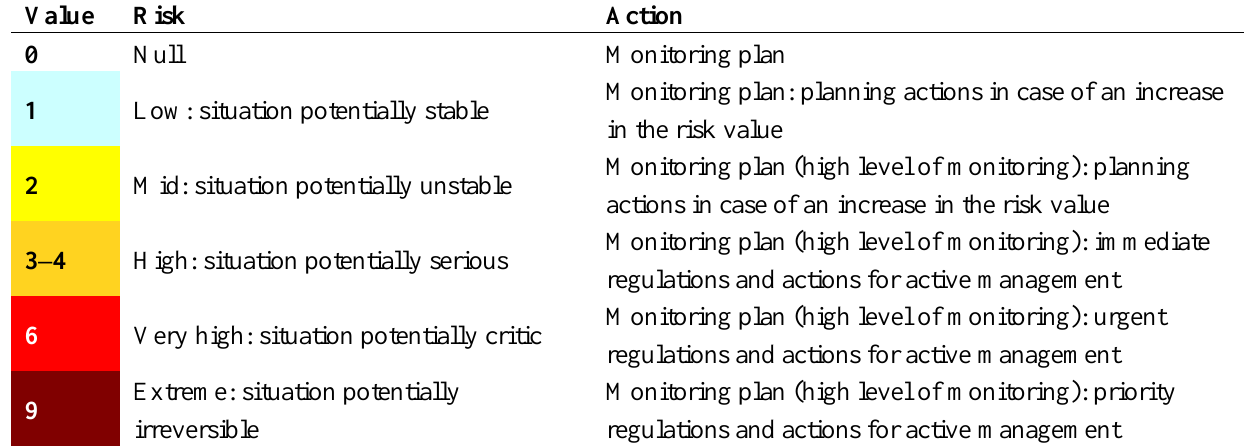
Table 4. Table for the interpretation of risk and relative